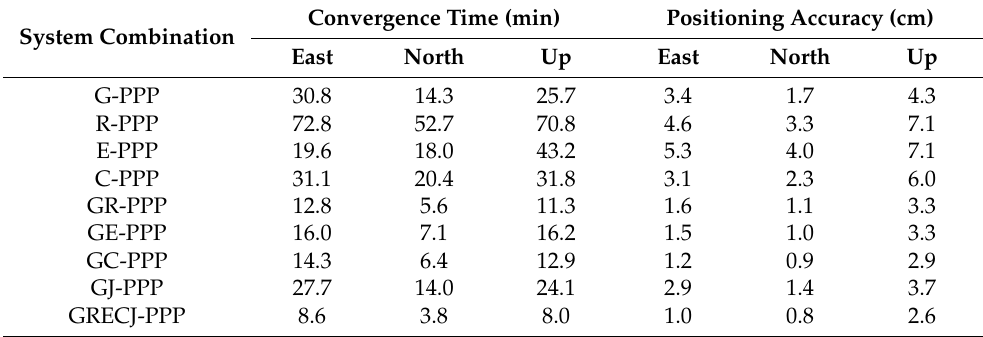
Table 13. Kinematic positioning accuracy and convergence time of post-processed PPP (long-term performance of PPP based on daily observations) with WHU products for different system combina- tions using the datasets from 29 stations spanning a